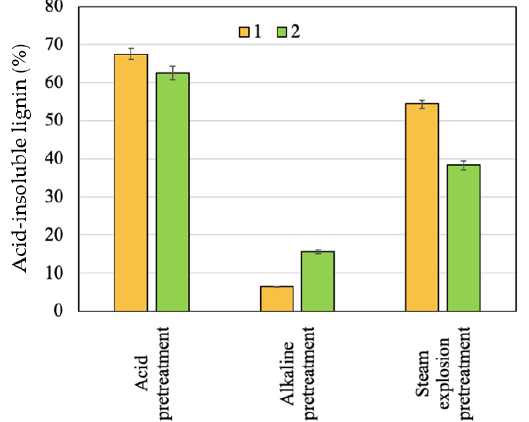
Figure 2. Effect of pretreatments on residual lignin content: 1—apricot seed shells; 2—walnut shells.